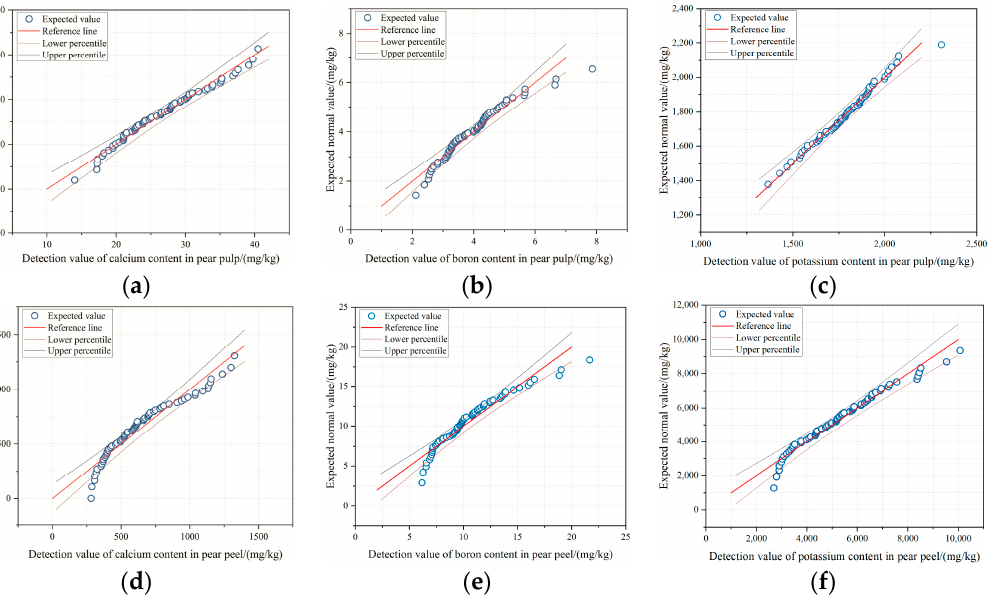
Figure 5. Curves fitted for prediction of mineral elements in pear pulp and peel. ( a ) Distribution of calcium content in pear pulp; ( b ) distribution of boron content in pear pulp; ( c ) distribution of potassium content in pear pulp; ( d ) distribution of calcium content in pear peel; ( e ) distribution of boron content in pear peel; ( f ) distribution of potassium content in pear peel.